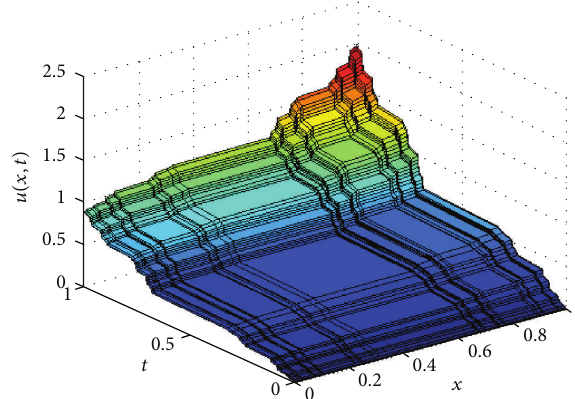
provides the components of the exact solution, which is local fractional continuous function, where these components are also local fractional continuous functions. Both the variational iteration method and the decomposition method within local fractional operators provide the solution in successive components. The methods are structured to get the local fractional series solution, which is a nondifferentiable